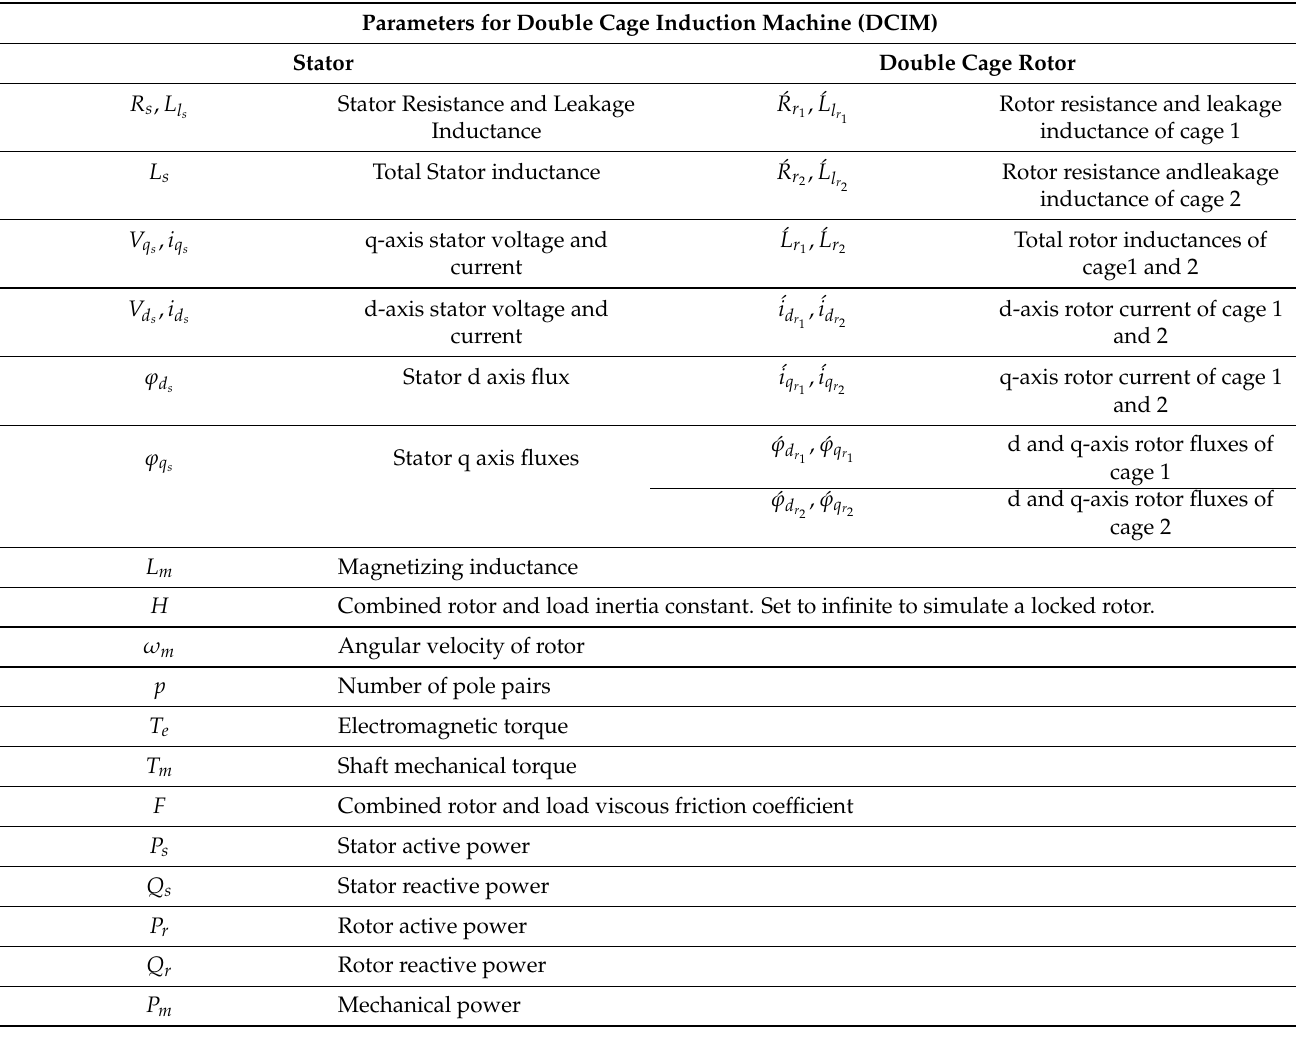
Table 1. Parameters used for the Double Cage Induction